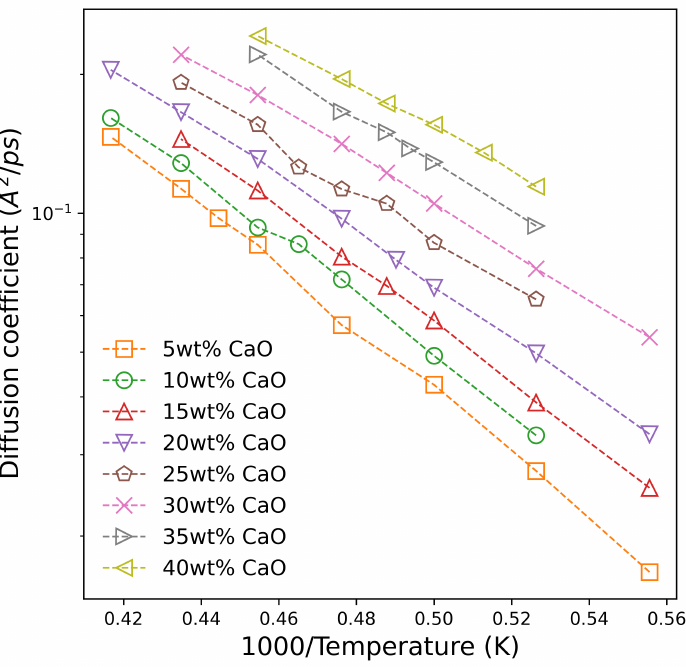
Figure 4. Simulated diffusion coefficient as a function of 1000 different CaO